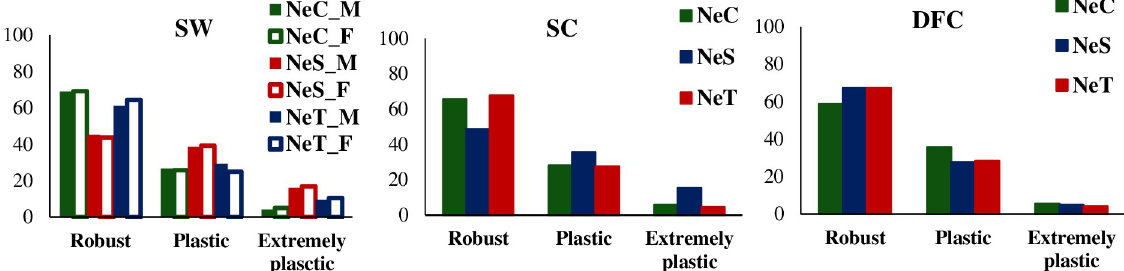
Fig 5. Observed frequencies of robust, plastic, and extremely plastic genotypes for Selection Weight (SW), Scrotal Circumference (SC), and for Days at First Calving (DFC) in three Nellore cattle lines (NeC, control; NeS, selection; and NeT traditional). NeC_M, males of the control line; NeC_F, females of the control line; NeS_M, males of the selection line; NeS_F, females of the selection line; NeT_M, males of the traditional line; NeT_F, females of the traditional